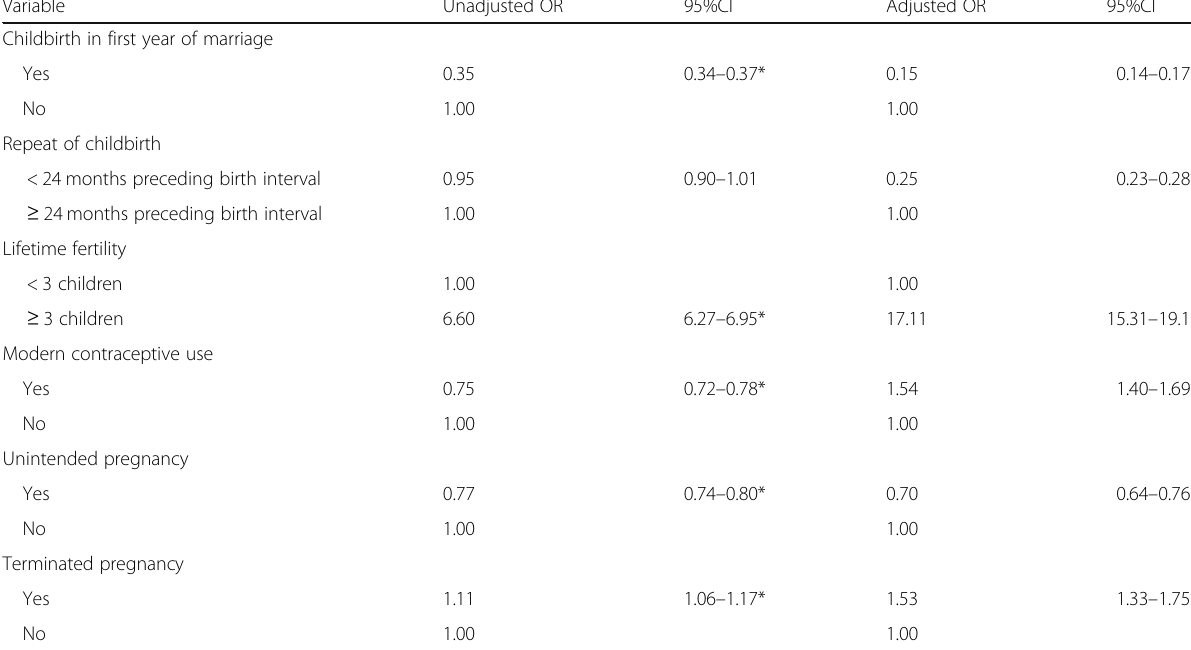
Table 4 Association between child marriage, fertility and fertility-control outcomes Variable Unadjusted OR